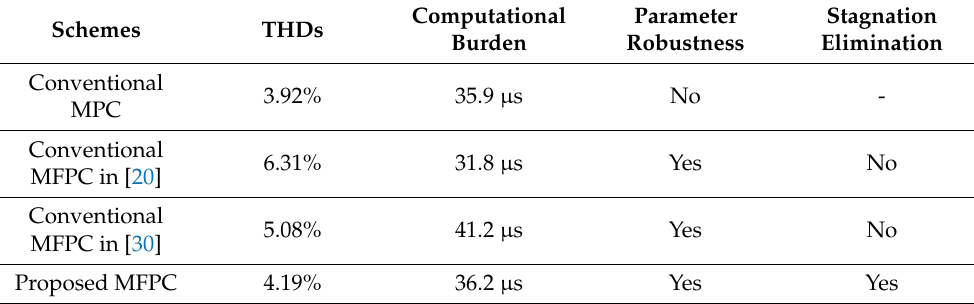
Table 3. Performance comparison of different control schemes.